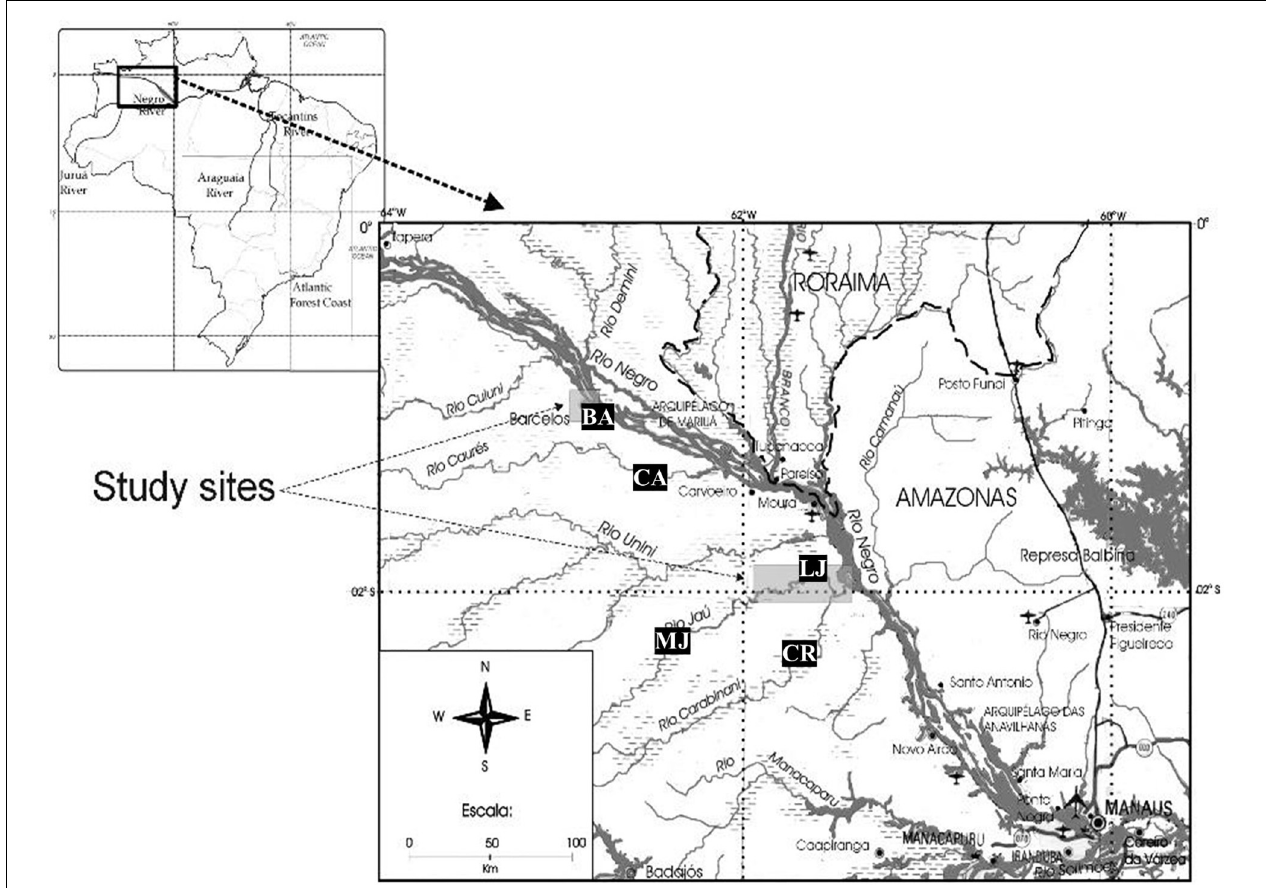
FIGURE 2 | Study area in the middle of the Negro River, Amazonas,